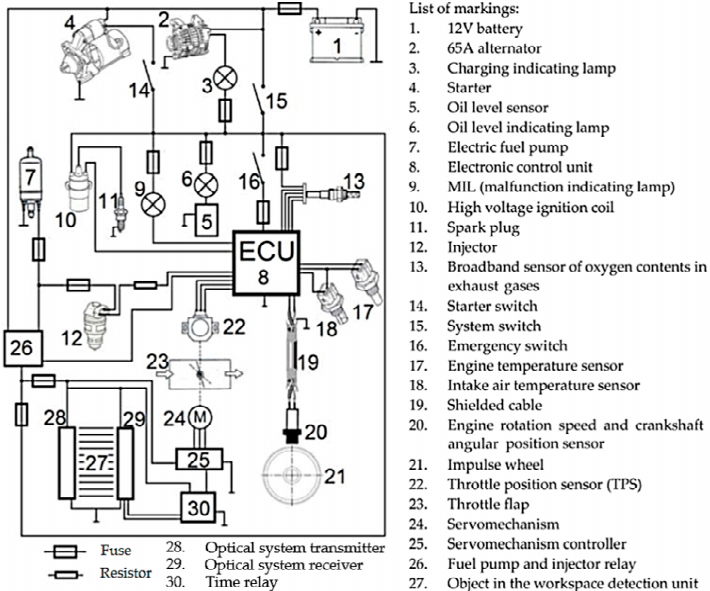
Figure 2. Schematic of the innovative injection-ignition system used in the German GX390 with a maintenance-free detection and adaptive chipper drive control system. Table 1. Technical specification of German GX390 engine in configuration: A: carburettor fuel supply system; B: electronic injection system; C: electronic injection system with adaptive